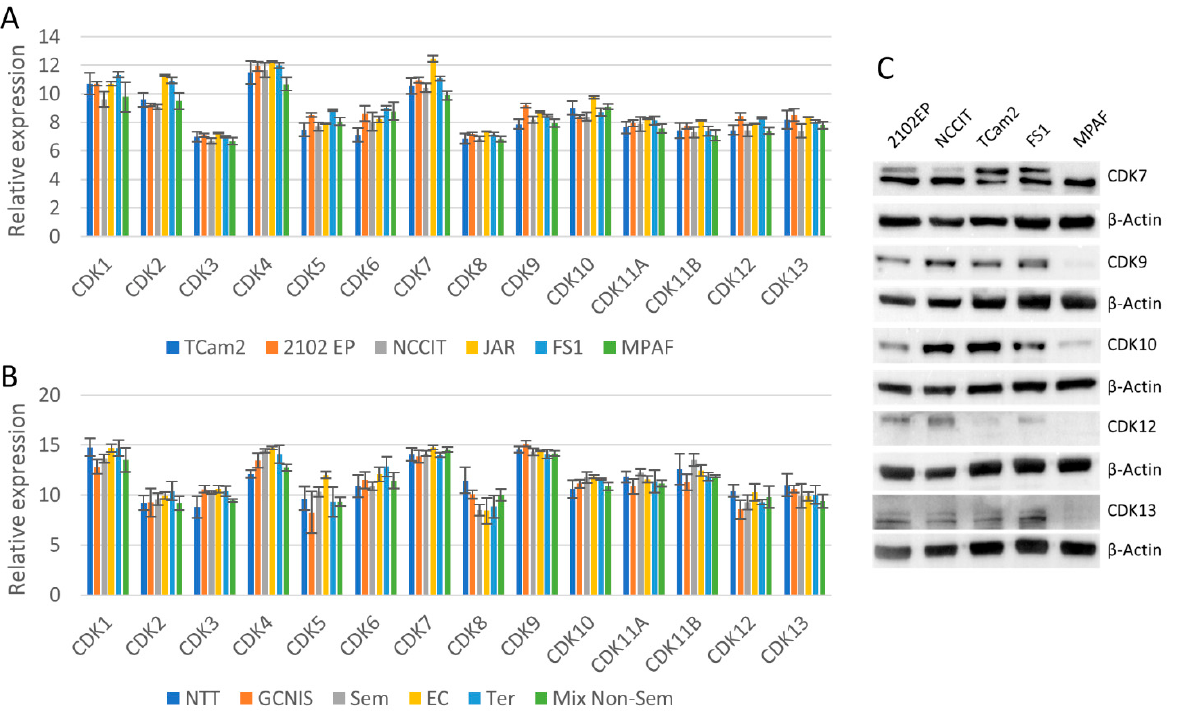
Figure 1. CDK expression in TGCT cell lines and TGCT tissues. ( A ) Meta-analysis of Illumina microarray data from TGCT cell lines (TCam2, 2102EP, NCCIT, JAR), a Sertoli cell line (FS1) and a fibroblast cell line (MPAF). ( B ) Meta-analysis of Affymetrix microarray data from tissues (NTT: normal testis tissues, GCNIS: germ cell neoplasia in situ, Sem: seminomas, EC: embryonal carcinomas, Ter: teratomas, Mix Non-Sem: mixed non-seminomas). ( C ) CDK protein levels in TGCT cell lines and control cells with corresponding β -Actin loading control below each target protein. Original Western Blots can be found at Supplementary